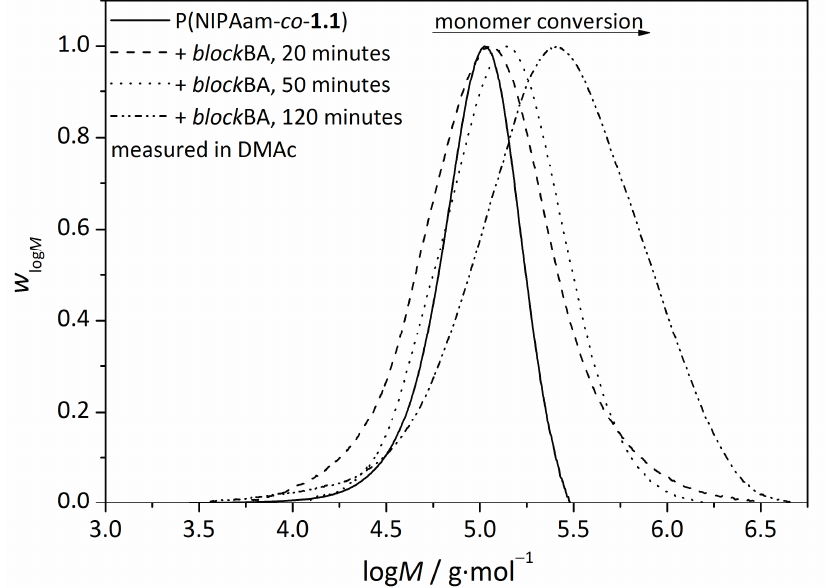
Figure 6. SEC-traces determined in DMAc of the block copolymerization of starpoly (NIPAam- co - 1.1 ) of M n = 70,000 g·mol − 1 (solid line) with 700 mmol·L − 1 BA using